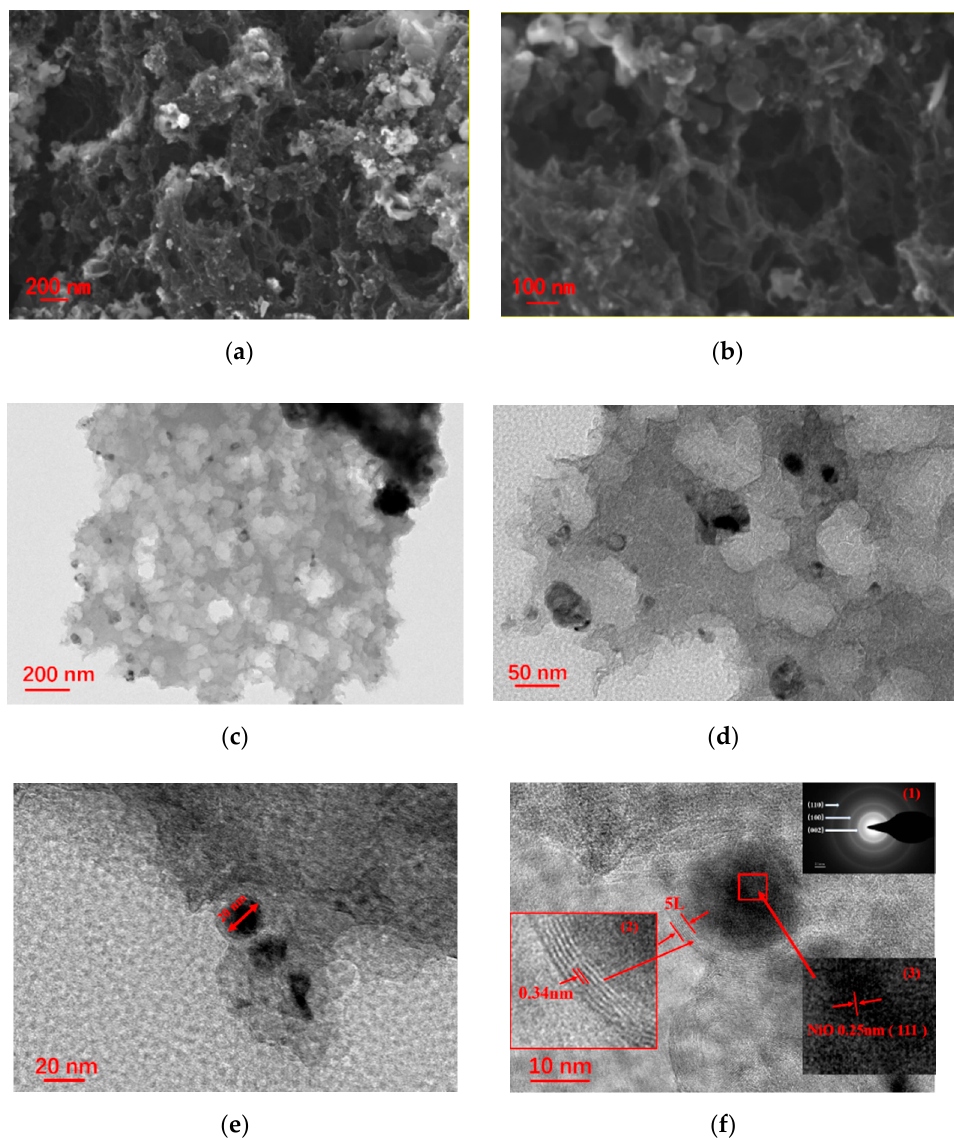
Figure 2. NiO/Ni@C-2 composite nanomaterials ( a , b ) SEM (scanning electron microscope), ( c , d ) TEM (transmission electron microscope), ( e , f ) HRTEM (High resolution TEM) spectra, inset (1) of Figure 2f is SAED (selected area electron diffraction) with the 2 1/nm of scale, inset (2) and (3) of Figure 2f the corresponding high-magnification TEM images.